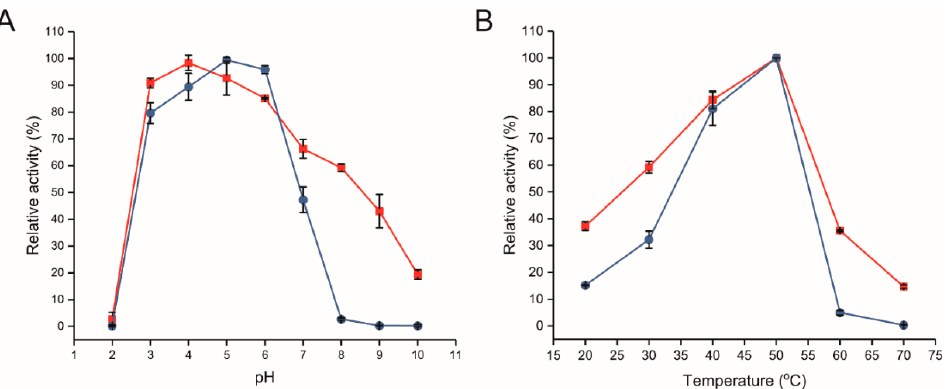
Figure 3. Effect of ( A ) pH and ( B ) temperature on the activity of free (blue line) and CLEAs R483A-LrInu (red line).